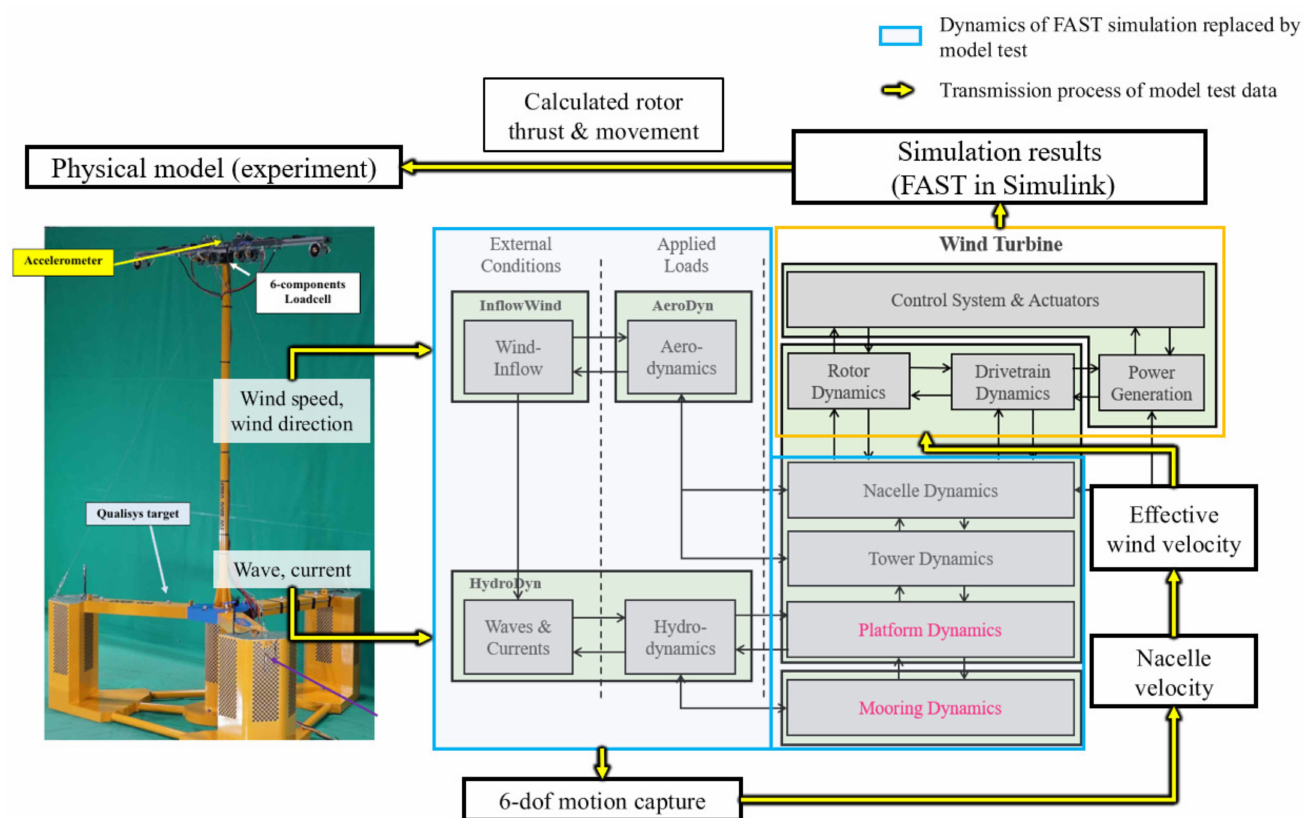
Figure 8. Flow chart of the model-in-the-loop simulation for a real-time model test with FAST